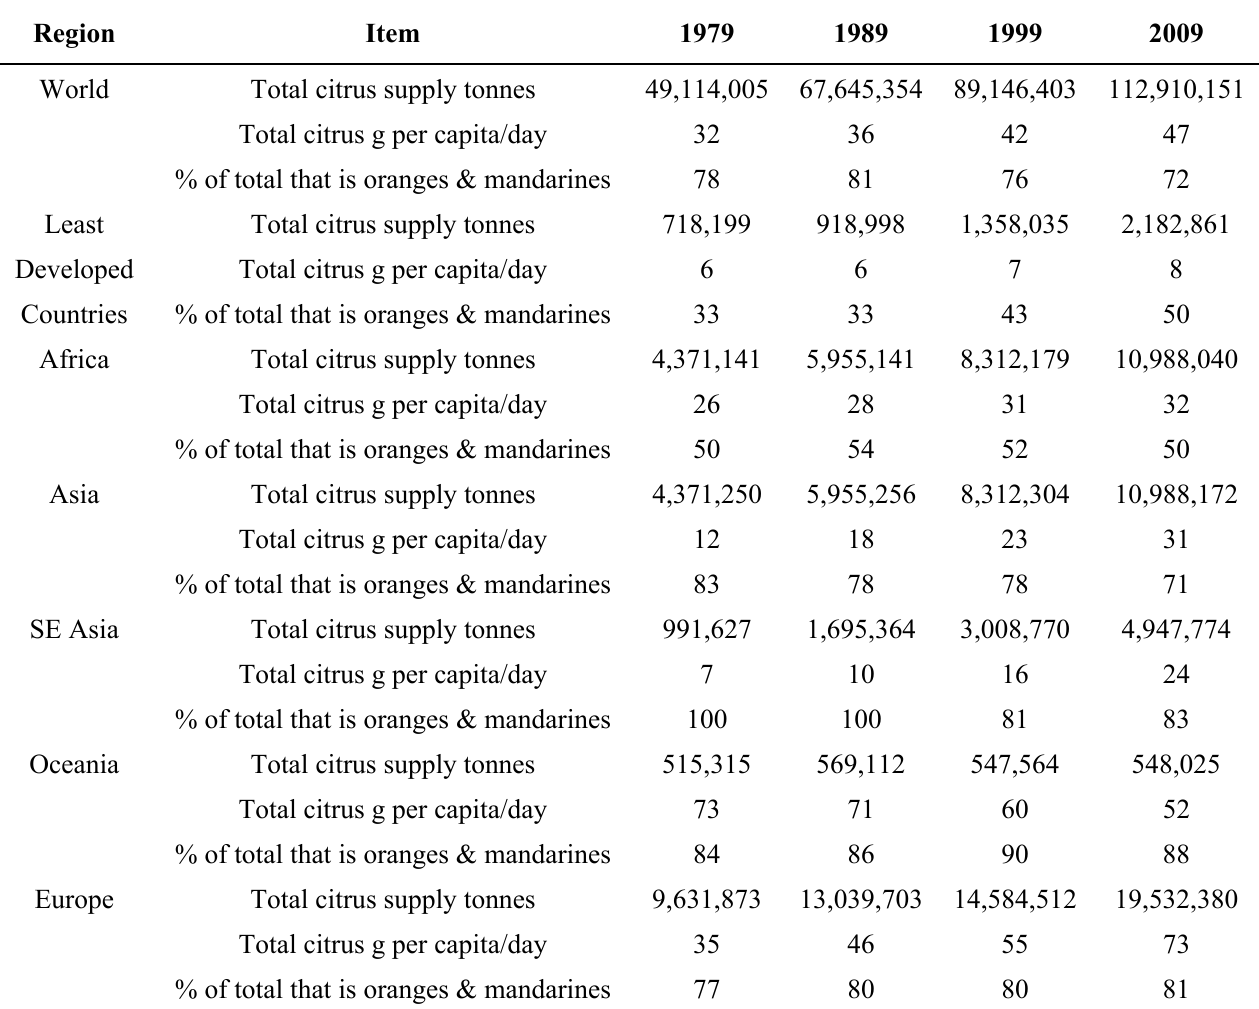
Table 1. Estimated supply and consumption of citrus by region, per person per day, and the percentage of citrus consumed that is oranges and mandarins 1979–2009